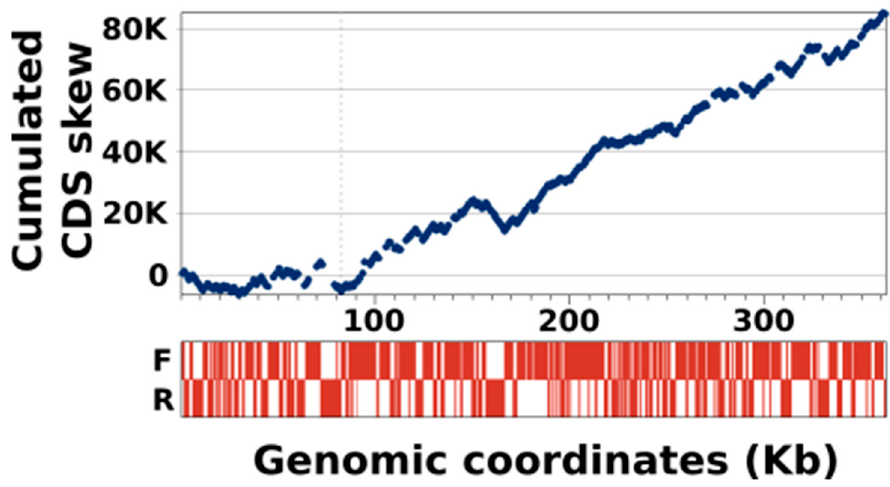
Figure 6. Cumulative CDS skew of the KV-LCC10 genome. The top panel shows the evolution of the cumulative CDS skew curve along the genome. The horizontal dashed line marks the position of the minimum value of the cumulative skew, near the coordinate 82Kb. The bottom panel shows the distribution of the coding sequence (in red) on the forward (F; upper lane) and reverse (R; lower lane) strands.